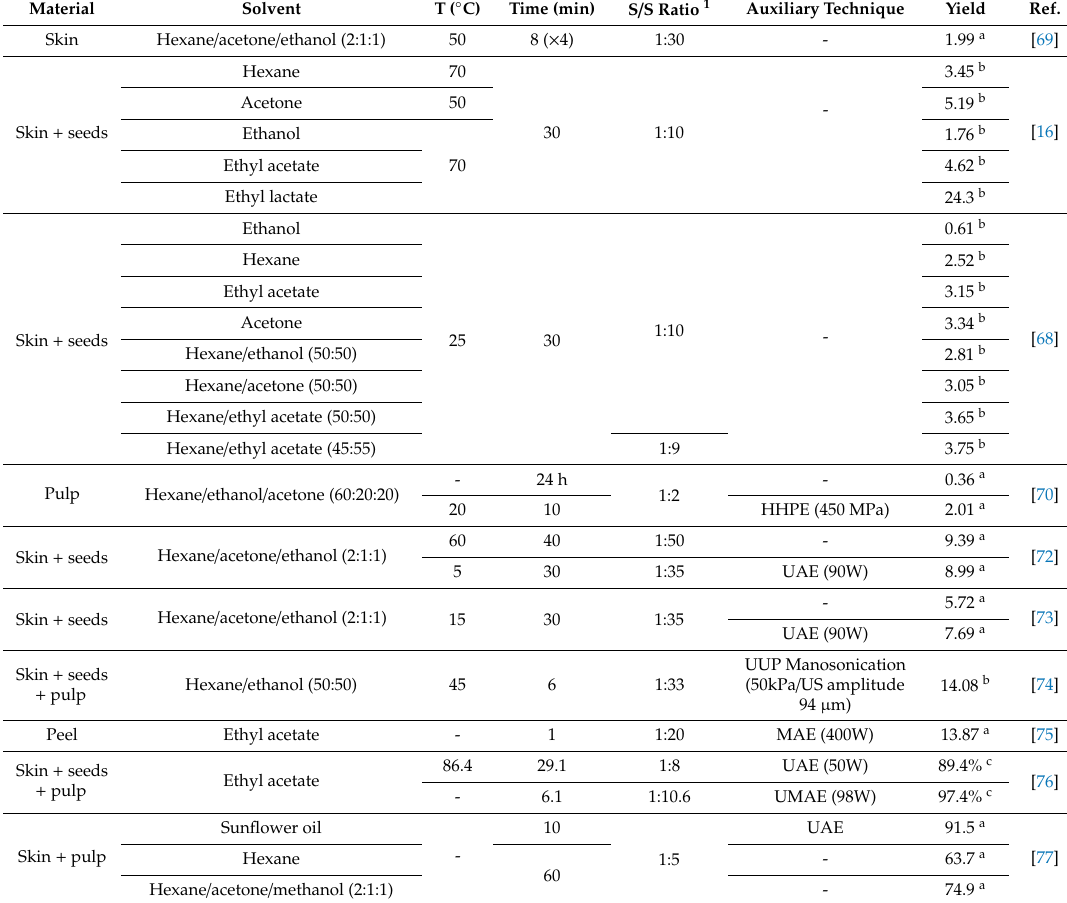
Table 1. Extraction conditions and organic solvents applied in recovering carotenoids from tomato